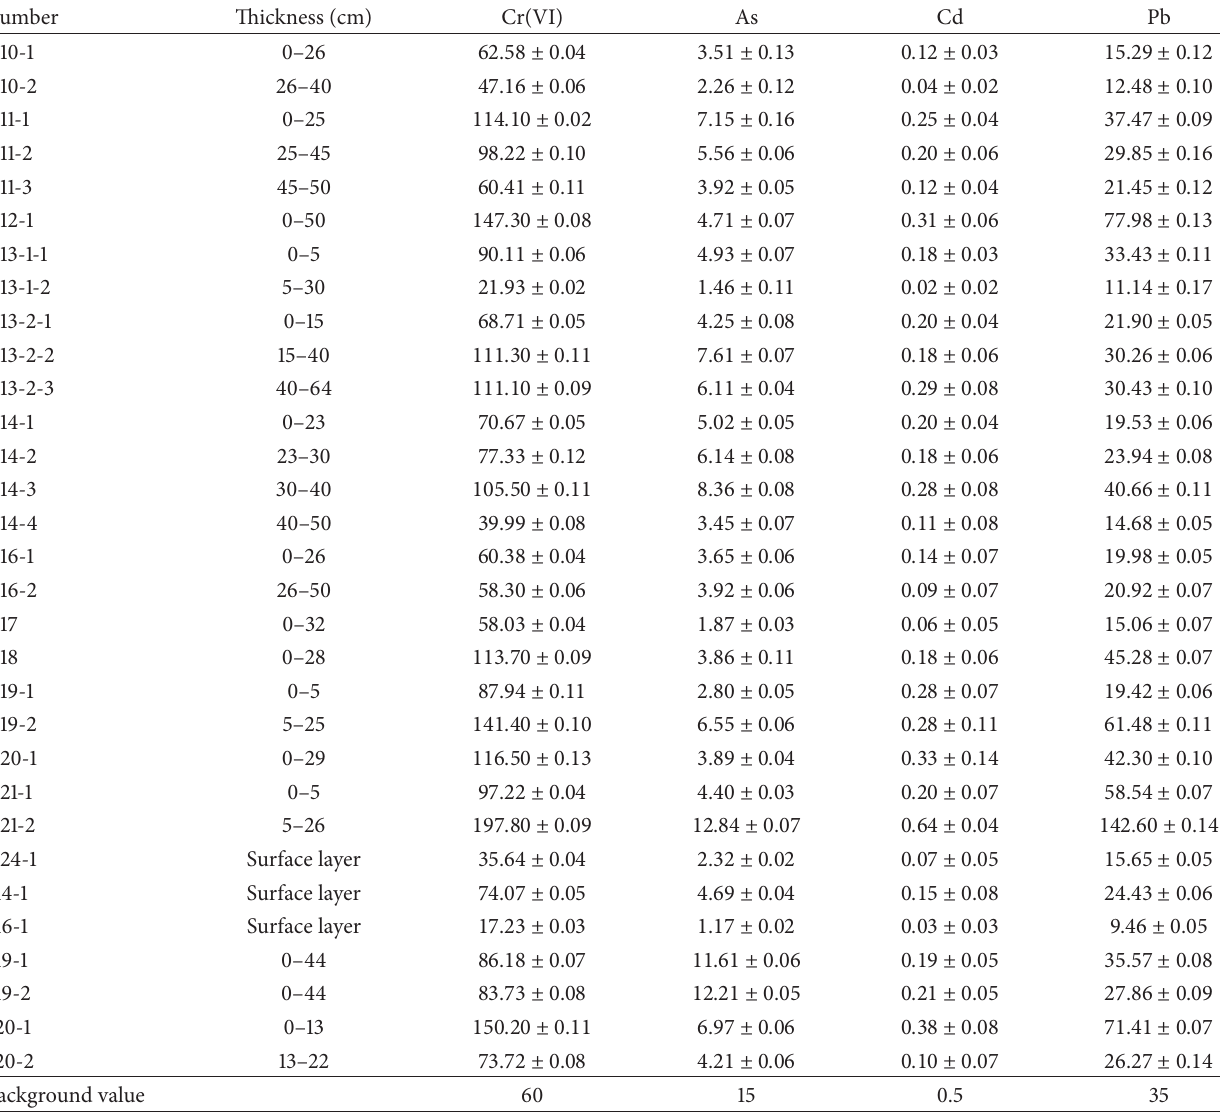
Table 4: Contents of heavy metals in sediment of Hun River